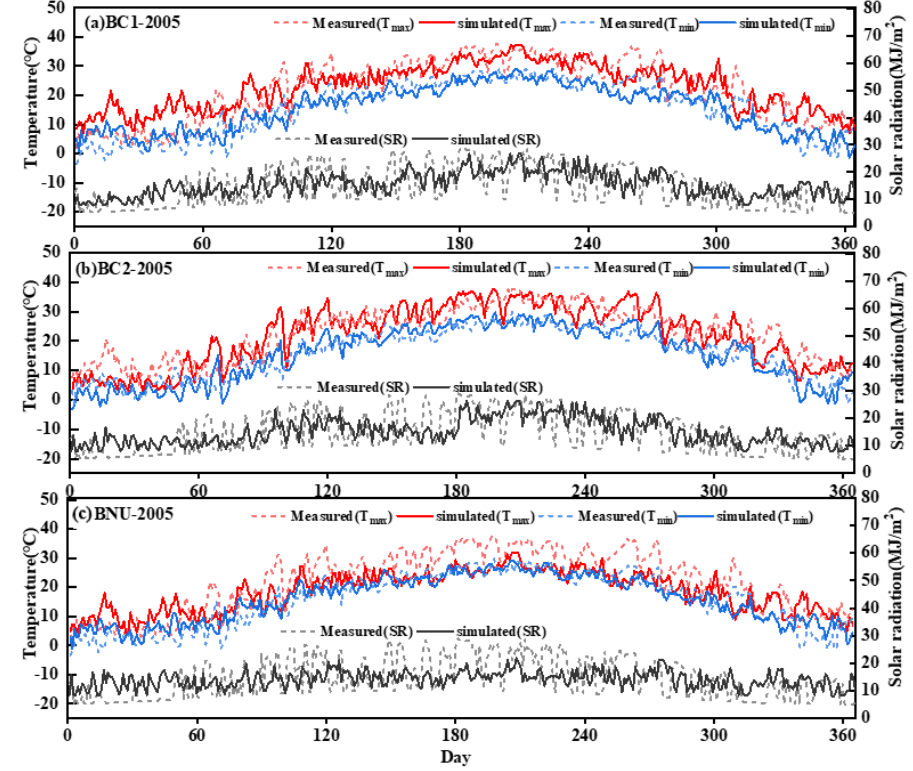
Figure 6. Comparison of measured and simulated daily solar radiation and temperature values in